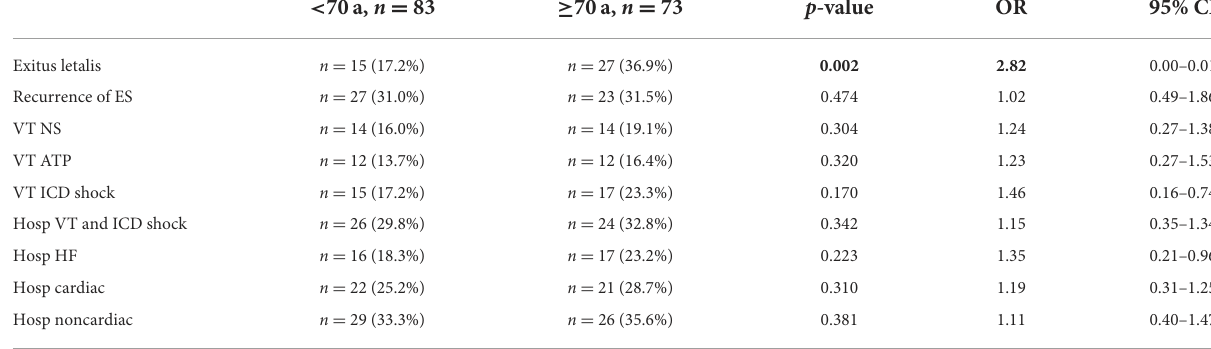
TABLE 3 Analysis between age < 70 vs. ≥